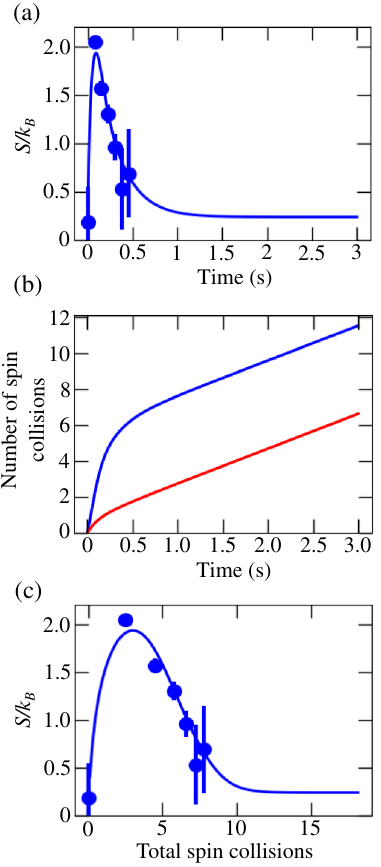
FIG. 10. Evolution of the entropy S of the probe. The Cs atoms ¼ 2 , immersed in a Rb bath at are initially prepared in m F; Cs ¼ 6 . 7 × 10 3 atoms. The magnetic field is T ¼ 366 nK with N Rb B ¼ 25 mG. Experimental points (circle) and theoretical pre- dictions (solid lines) are shown. (a) Time evolution of the entropy of the probe S . (b) Time evolution of the mean number of spin collisions: in red the mean number of endoergic spin collisions and in blue the mean number of exoergic spin collisions. (c) The entropy of the probe as a function of the total number of spin collisions is